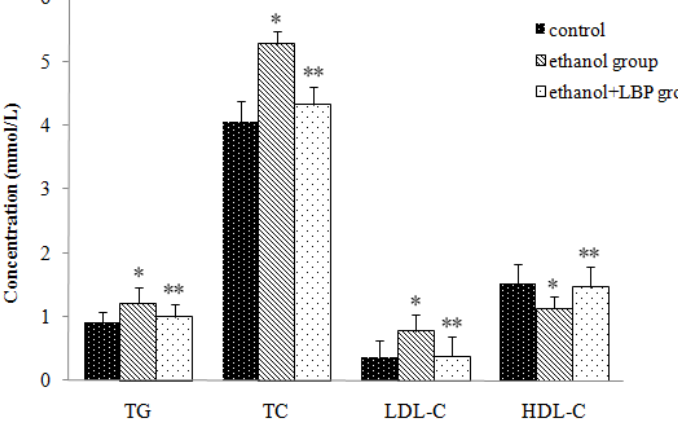
Figure 2. Effects of LBP on serum lipid levels in rats. Values are expressed as mean ± SD for 12 rats in each group. * p < 0.01, ethanol group vs. control group. ** p < 0.01, ethanol + LBP group vs. ethanol group.